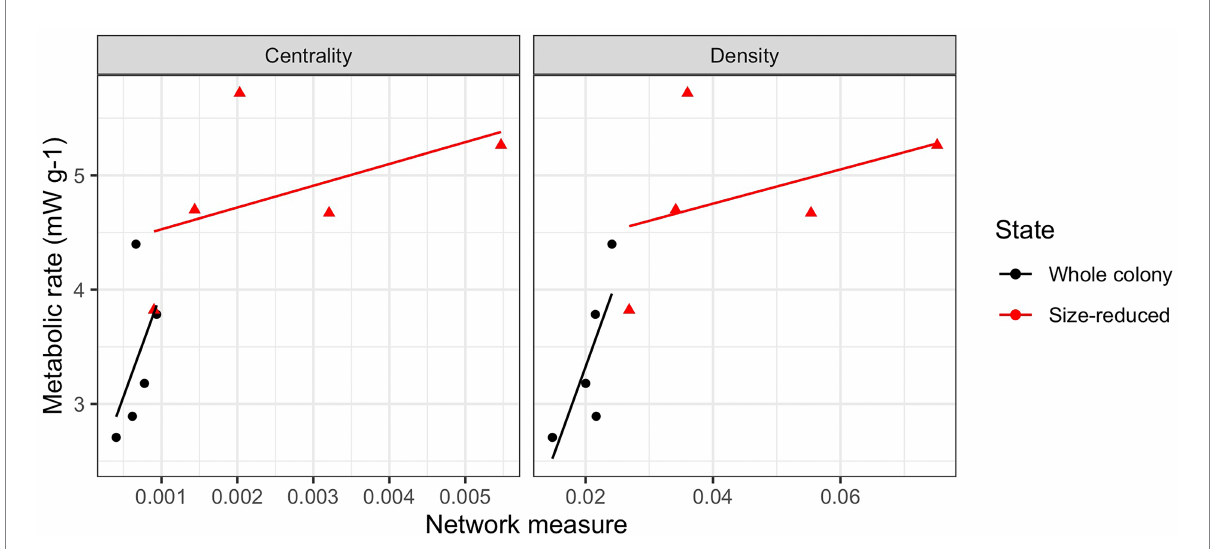
FIGURE 2 Correlations between network attributes and colony metabolic rates. Network centrality and density correlated with metabolic rates in a consistent manner both within treatment groups (whole colonies and size-reduced colonies) and between them. In both cases, increasing network centrality and density correlated positively with increases in the mass-specific metabolic rates of the